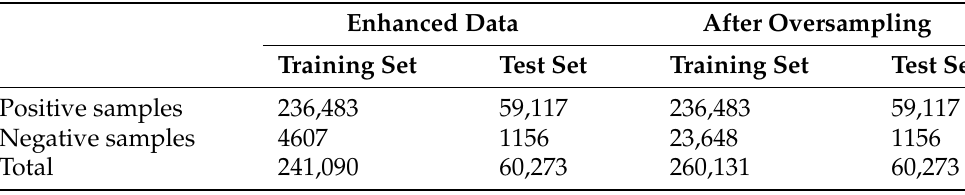
Table 1. Sampling statistics. For the enhanced structured dataset, we report the number of positive and negative samples both in the training set and test set, both before and after oversampling,